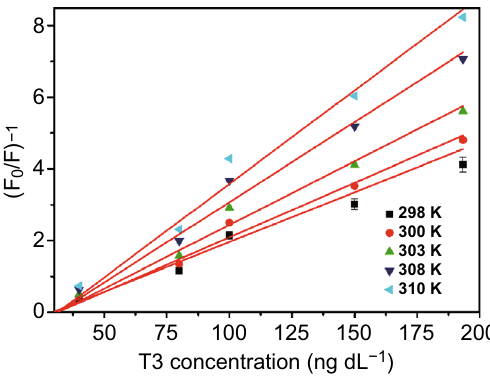
Fig. 16 Luminescence decay curves of Tb-SA films with and with- out the addition of Cu 2+ . Reproduced with permission from Ref. [32].